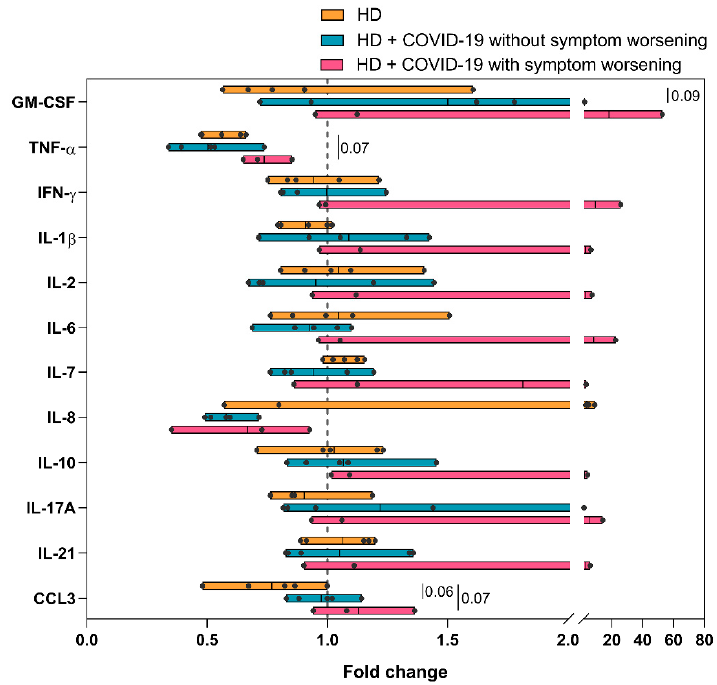
Figure 4. Change in serum cytokine levels after hemodialysis. Comparison of fold change in cytokine levels pre- and post-hemodialysis between uninfected HD patients, HD + COVID-19 patients without worsening of COVID-19 symptoms and HD + COVID-19 patients with worsening of COVID-19 symptoms after receiving hemodialysis. Dotted line represents unchanged cytokine level.